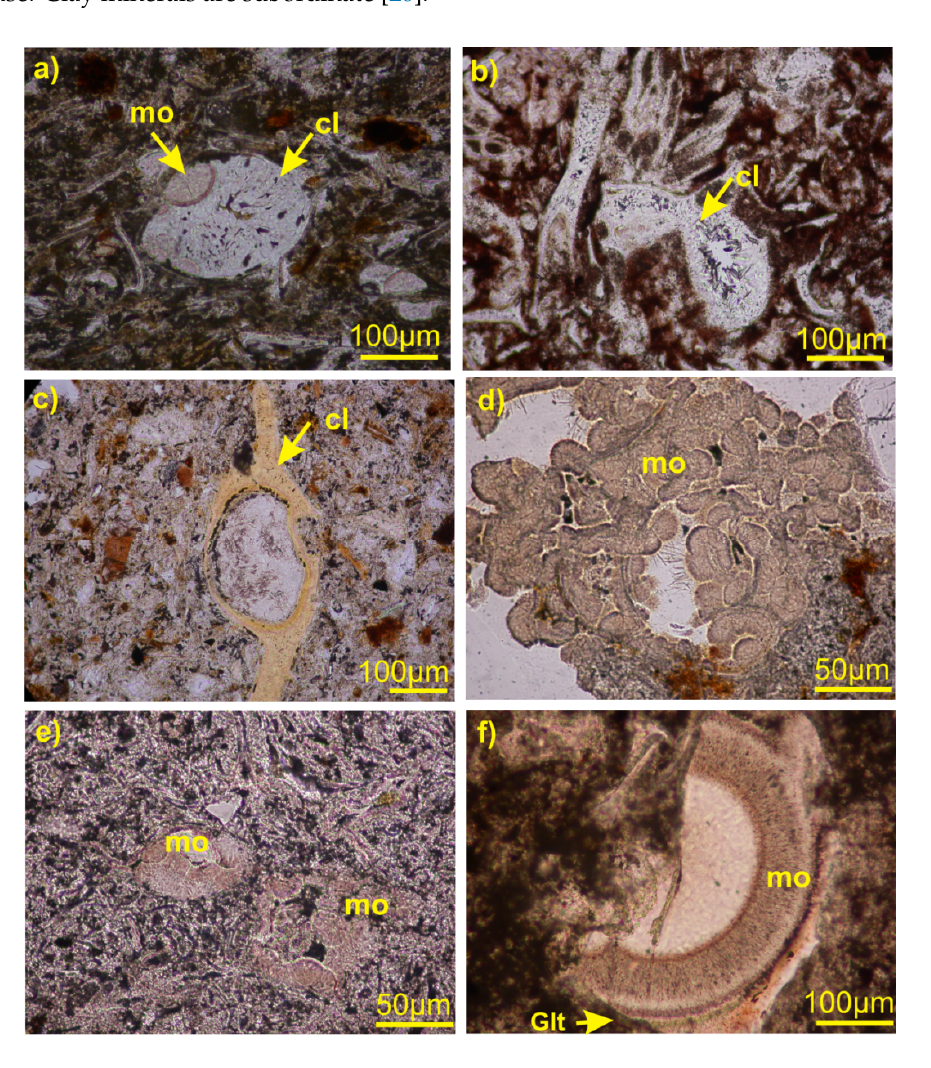
Figure 6. Microphotographs of zeolites in samples observed under a plane-polarized transmitted light: ( a ) armored lapilli altered into clinoptilolite aggregate and spherulitic mordenite, sample N2;